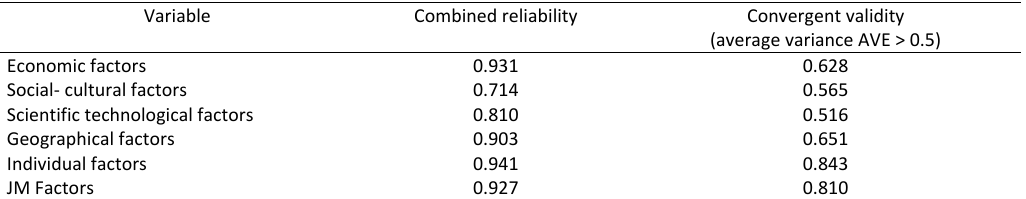
Table 2: the average of combined reliability and convergent validity Variable